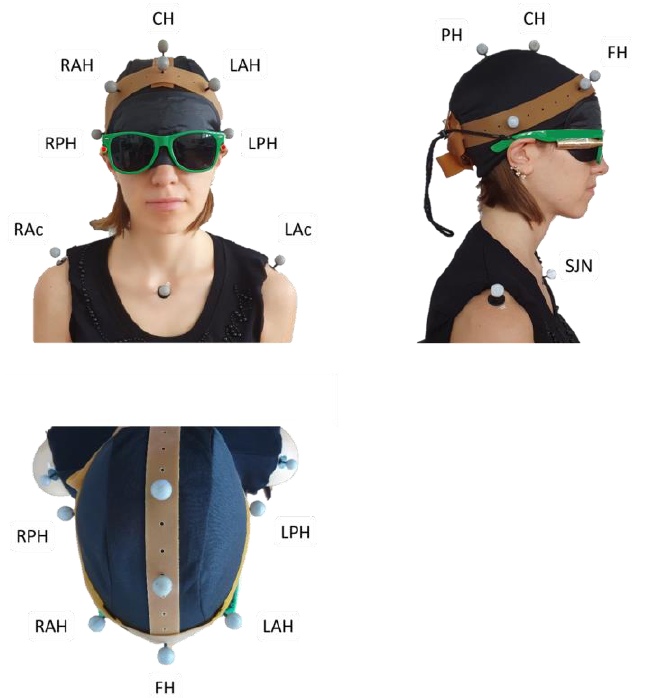
Figure 1. Personalised marker model (rubber “crown” set up). FH: frontal head marker; CH: central head marker; PH: posterior head marker; RAH and LAH: right and left anterior head markers; RPH and LPH: right and left posterior head markers; RAc and LAc: right and left acromion; SJN: sternum jugular notch. Two bullet-like laser pointers, projecting a red light beam, are fixed on a pair of glasses tightened posteriorly. The participant wears a sleeping mask to prevent visual cues. The subject’s gaze points downwards in the bottom panel (horizontal view) and rightwards in the right panel (sagittal view). The subject’s spatial orientation can also be inferred by looking at the corresponding marker labels.